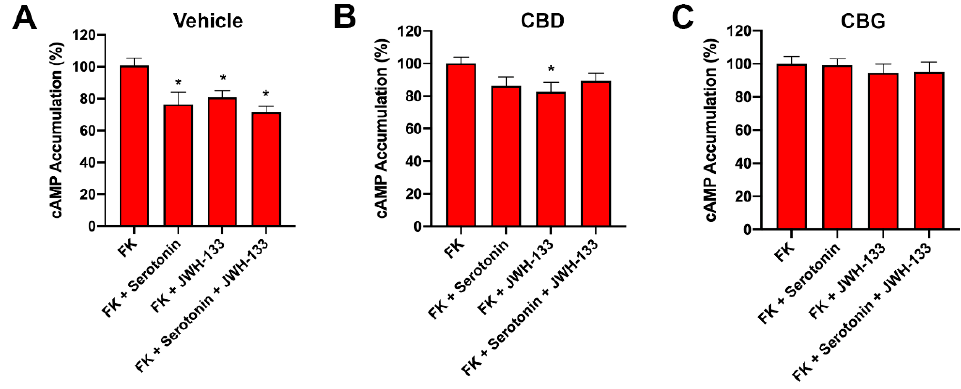
Figure 6. Effect CBD or CBG on the receptor functionality in GOD primary cortical neurons. Mouse primary striatal neurons were treated with vehicle ( A ), 200 nM of CBD ( B ), or 200 nM of CBG ( C ) for 30 min prior GOD for 4 h. Then, neurons were treated with selective agonists, 200 nM JWH-133 or 200 nM serotonin. cAMP levels were expressed as a percentage versus 0.5 μ M forskolin treatment. Values are the mean ± S.E.M. of 8 different experiments performed in triplicate. One-way ANOVA followed by Dunnett’s multiple comparison post hoc tests were used for statistical analysis. * p < 0.05 versus forskolin treatment.